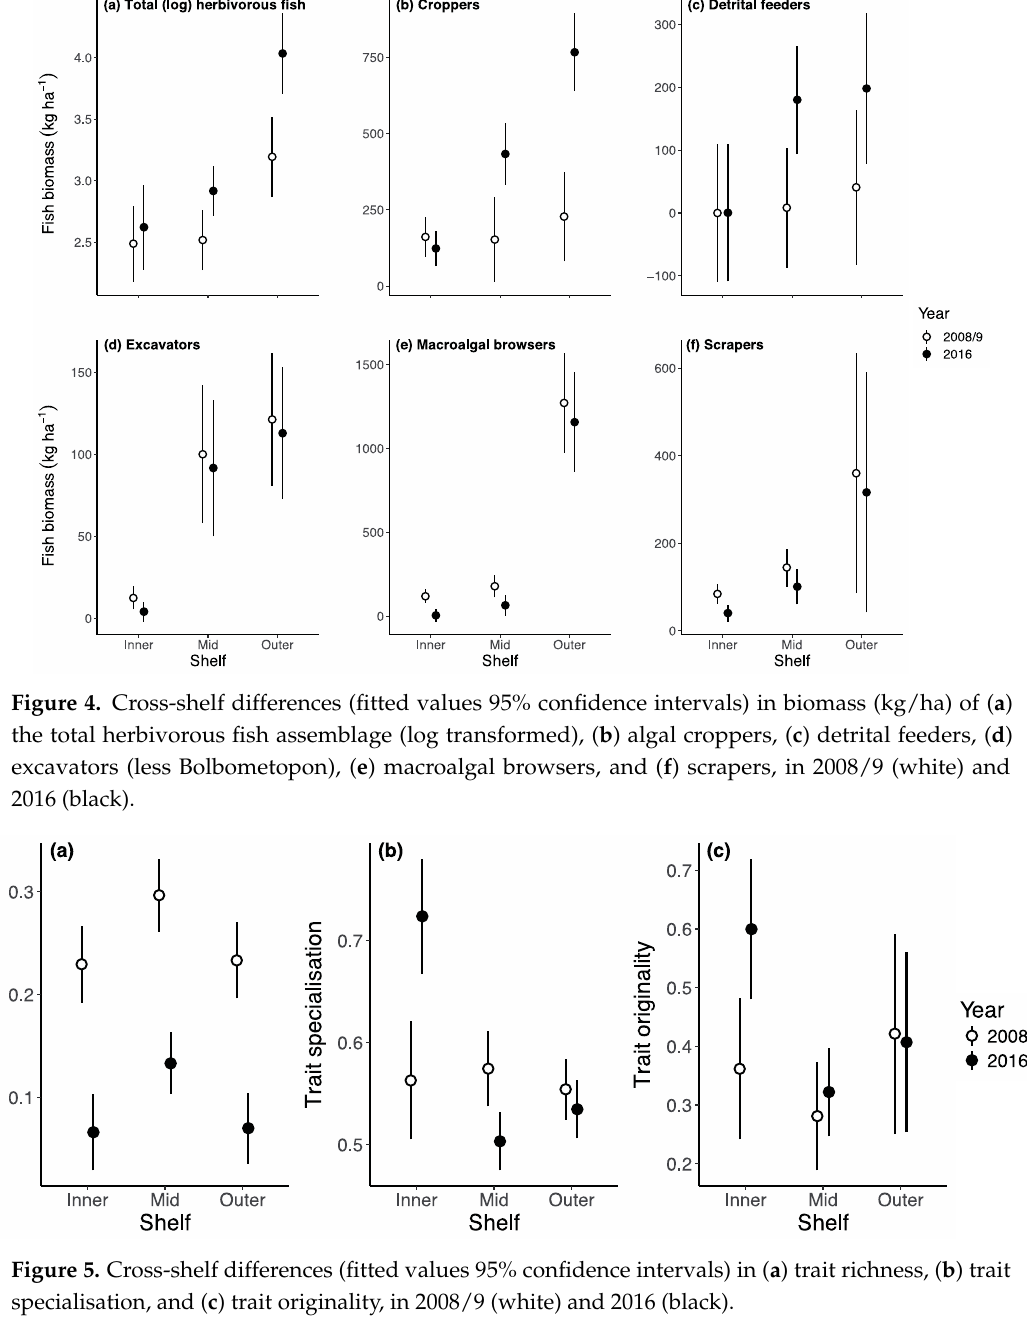
Figure 5. Cross-shelf differences (fitted values 95% confidence intervals) in ( a ) trait richness, ( b ) trait specialisation, and ( c ) trait originality, in 2008/9 (white) and 2016 (black).